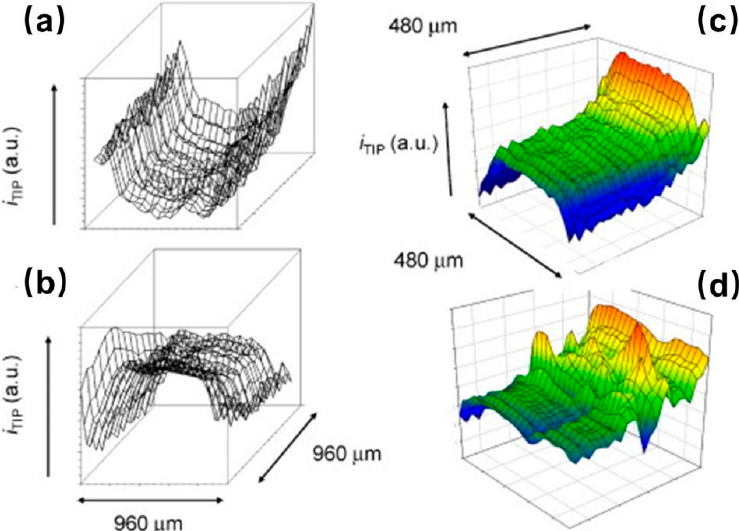
Figure 8 . SECM images of ( a – c ) single-stranded DNA (ssDNA) and ( d ) Double-stranded DNA (dsDNA) fibers immobilized on Pt substrate electrode in contact with a 2-mM ferrocene plus 1-mM L solution in 0.10 M Bu 4 NPF 6 /DMSO. ( a ) E S = +0.65 V; E T = +0.40 V; ( b – d ) E S = − 1.25 V, E T = − 0.45 V. Copyright (2014) Elsevier Ltd.